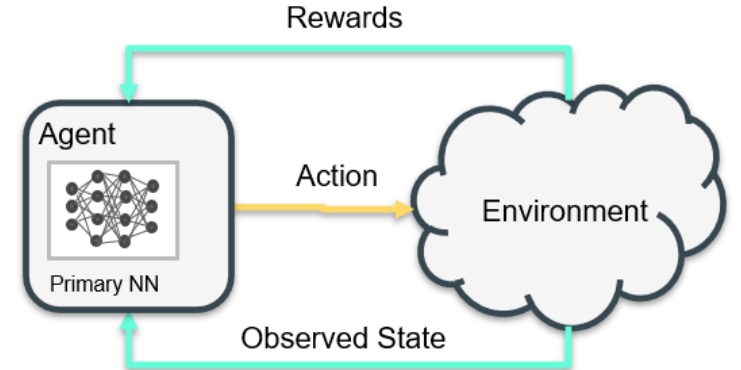
Figure 5. Deep Q Learning.